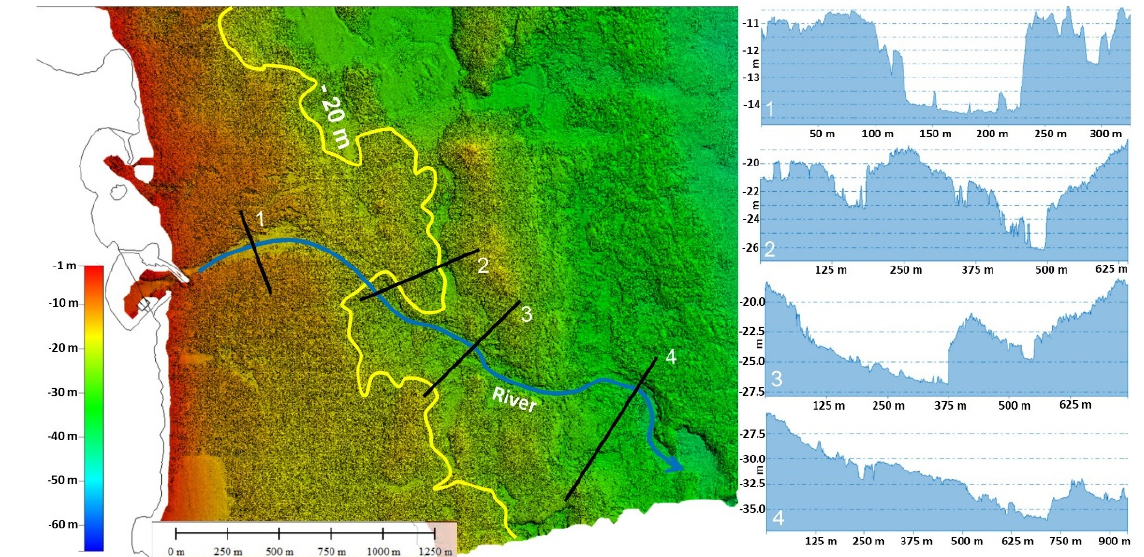
Figure 14. Proximal portion of the southern sector. Profiles 1, 2, 3, and 4 show the morphological variations from northwest to southeast of the main incision described in the area.